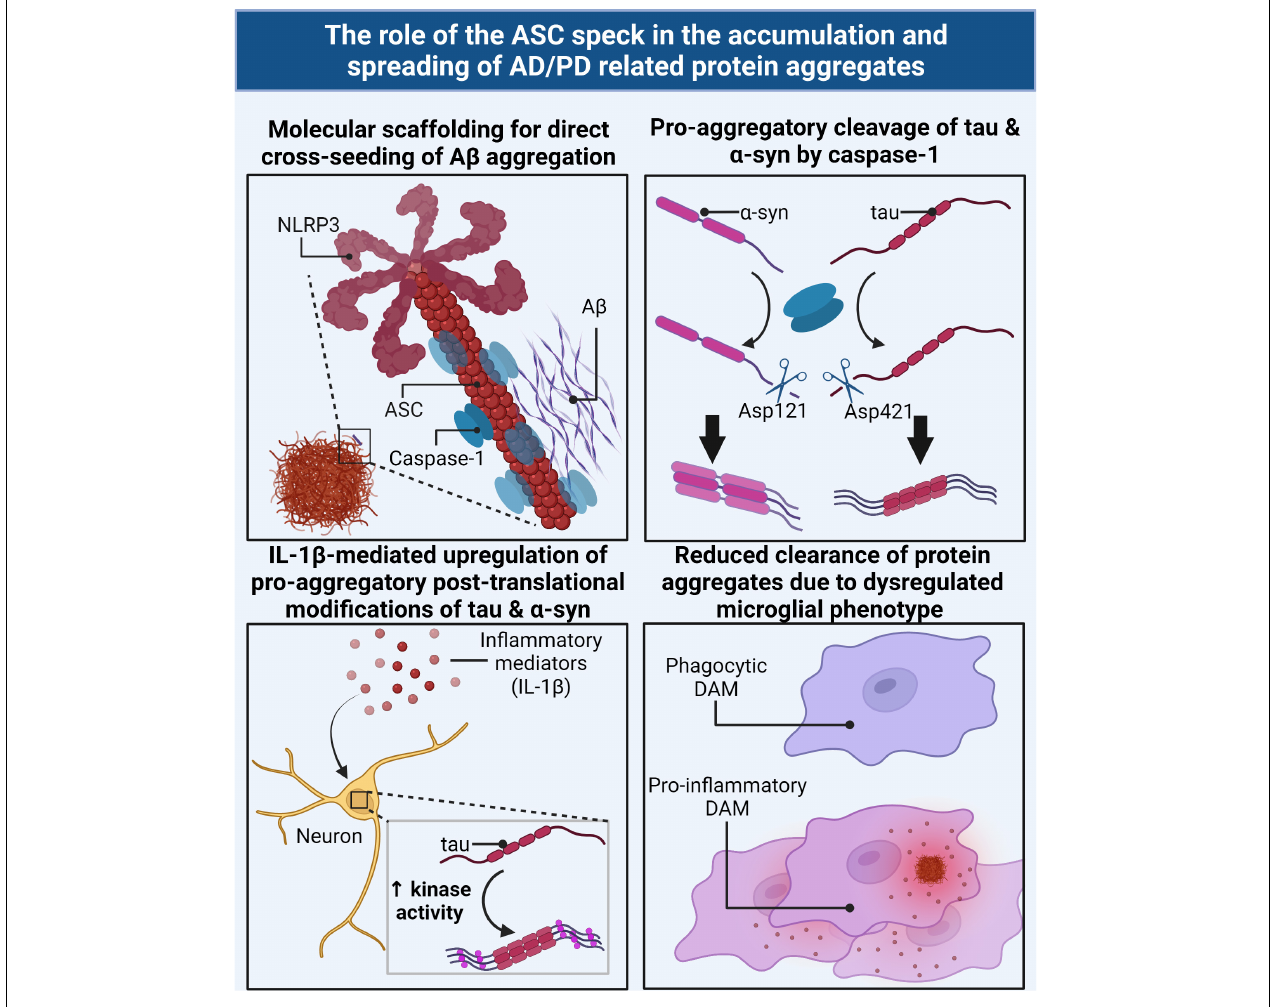
FIGURE 3 | The ASC speck directly and indirectly contributes to the accumulation and spreading of AD/PD related misfolded protein aggregates via several mechanisms. The ASC speck can directly cross-seed the aggregation of A β by serving as a molecular scaffold for aggregation (top left) . Caspase-1, the effector component of the inflammasome/ASC speck, can directly cleave tau and α -syn monomers into a pro-aggregatory form for seeding nucleation (top right) . IL-1 β , the downstream product of the ASC speck, can act as a cellular signal to upregulate key enzymes for the pro-aggregatory PTMs of tau and α -syn (bottom left) . The ASC speck contributes to the dysregulation of protective disease-associated microglia (DAMs) and subsequent skewed pro-inflammatory phenotype resulting in a decrease in phagocytic clearance of AD/PD related misfolded protein aggregates (bottom right)